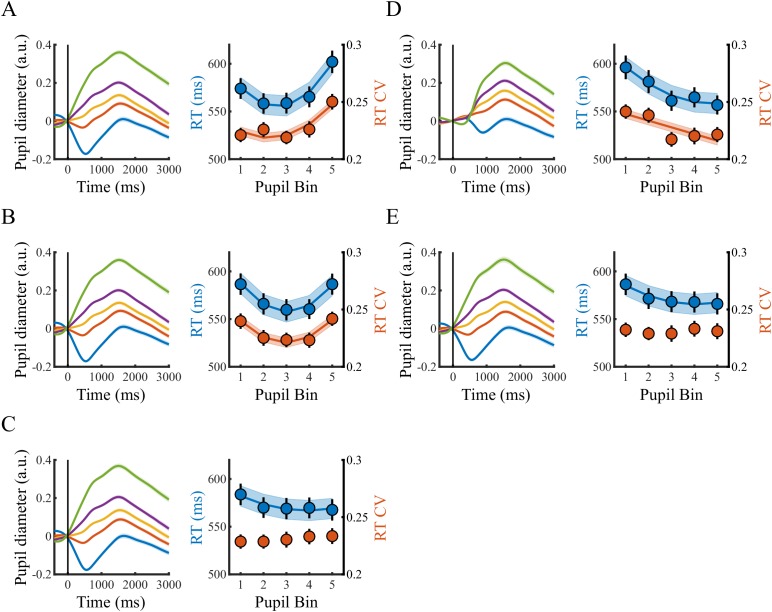
Relating various measures of the phasic pupil response to behavioural performance.The pupil time course (left) and behavioural performance (right) as measured by RT and RTcv binned by: (A) the mean pupil diameter in the 400 ms around RT; (B) the mean pupil diameter in the 400 ms around RT in which fluctuations in the measurement of pupil diameter due to fluctuations in RT were removed via linear regression; and (C–E) the mean pupil diameter (C) the slope as measured by fitting a straight line (least squares) (D) and linear projection (E) during the 400 ms around the maximum of the derivative of the pupil input response function (636 ms after target onset) used for the GLM analysis. Error bars and shaded regions denote ±1 standard error of the mean (SEM). Stats, linear mixed effects model analyses (Statistical analyses).